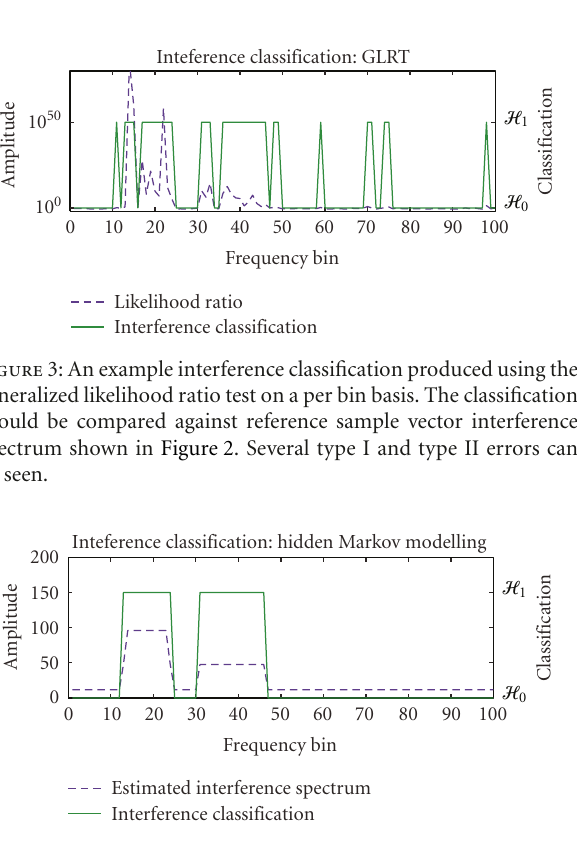
Figure 4: An example interference classification produced using hidden Markov modelling. The classification should be compared against reference sample vector interference spectrum shown in Figure 2. In this example, this method failed to detect the low power interferer occupying frequency bins 64 through to 77, but otherwise produced an accurate